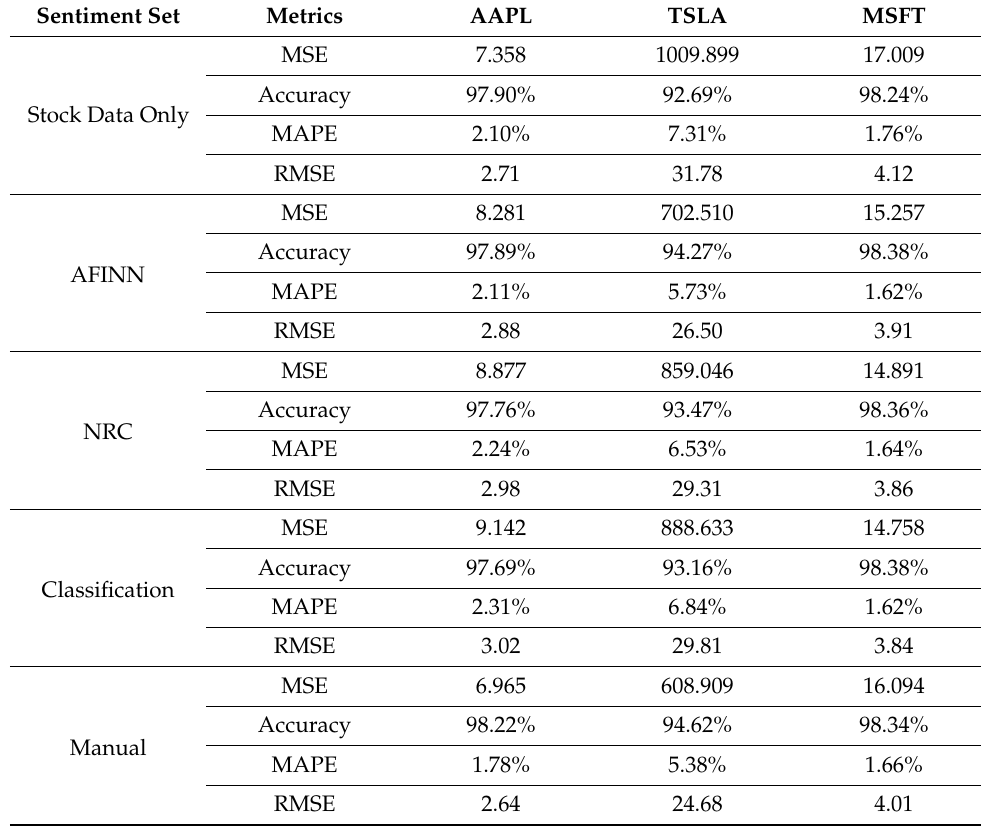
Table 9. Comparison of Results of Sentiment Methods after